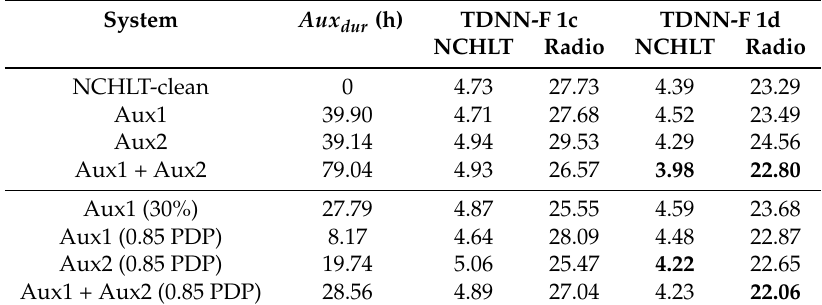
Table 9. PERs for two Afr test sets and TDNN-F systems trained on different augmented training sets (lowest PERs in